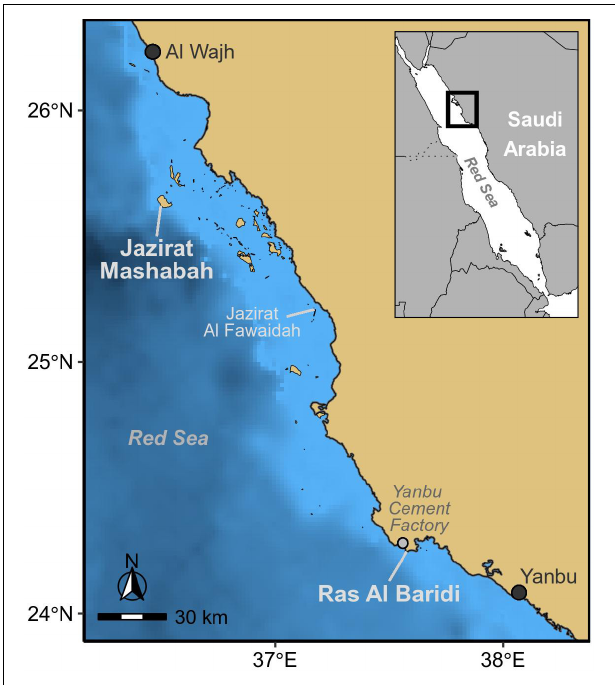
FIGURE 1 | Study sites at the major rookeries of green turtles in the Red Sea; Jazirat Mashabah, and Ras Al